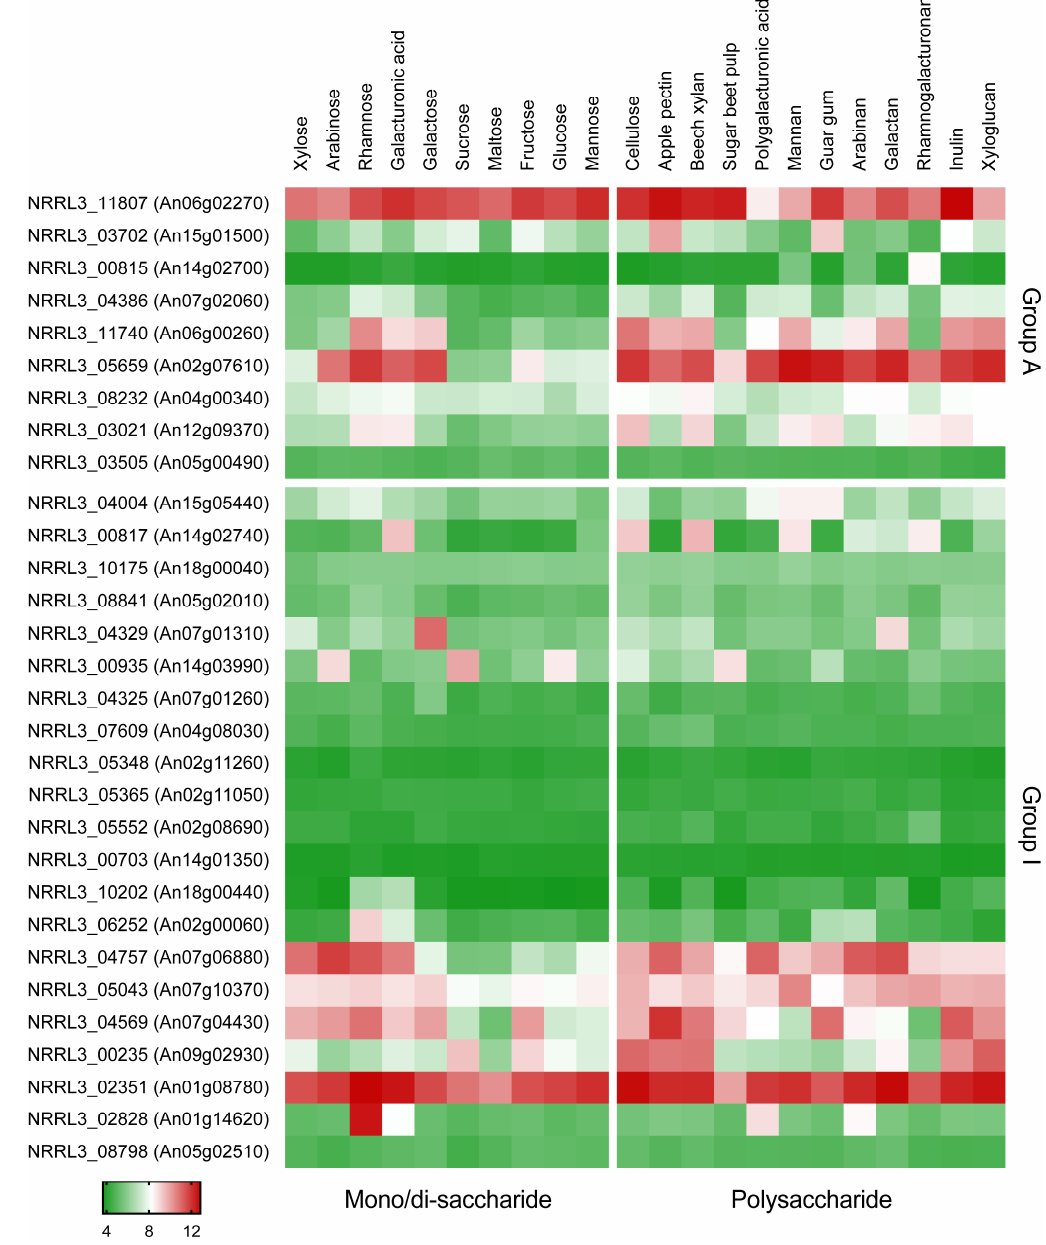
Figure 1. Expression profiles of putative sugar transporters in A. niger on diverse carbon sources [21]. Protein IDs of A. niger NRRL3 are shown in the figure, and numbers in brackets reflect protein IDs from A. niger CBS 513.88. The color code represents averaged and logged expression values (FPKM + 1) of replicates. The heat map was drawn using GraphPad Prism (https://www.graphpad.com/, accessed on 11 January 2023). Group A and I refer to the phylogenetic grouping of transporters, as described previously